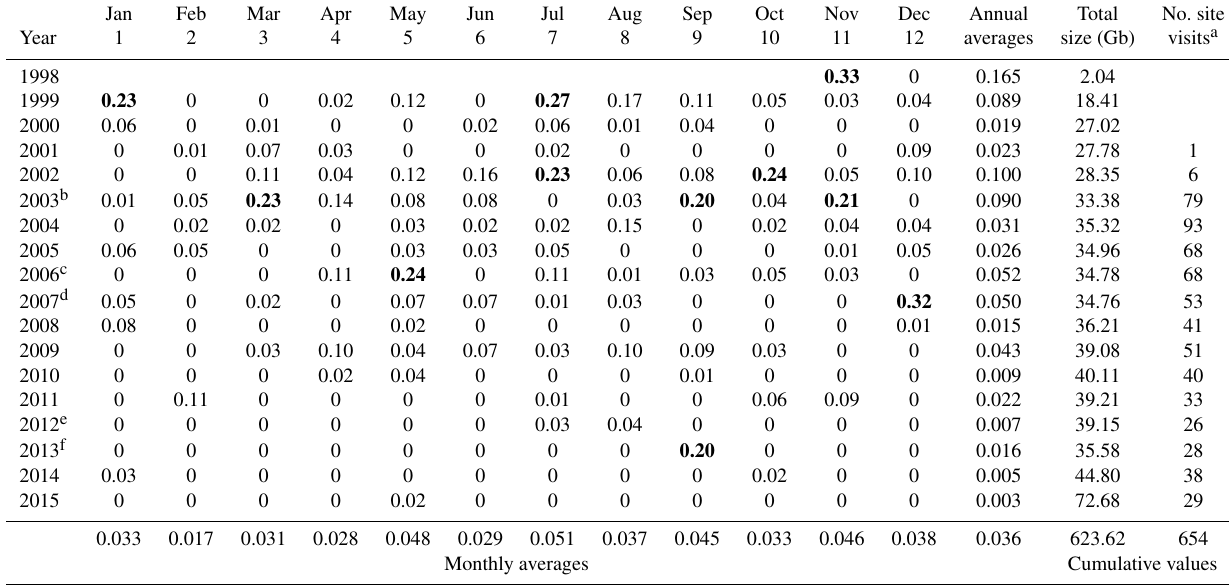
Table 3. The fraction of missing high-rate (10Hz) data from the FAST CR23X data logger shown by month and year. Months with greater than 20% of high-rate data missing are highlighted in bold. In the two right-hand columns, the total size (in gigabytes) of the raw, high-rate binary data collected for each year and the approximate number of site visits per year are